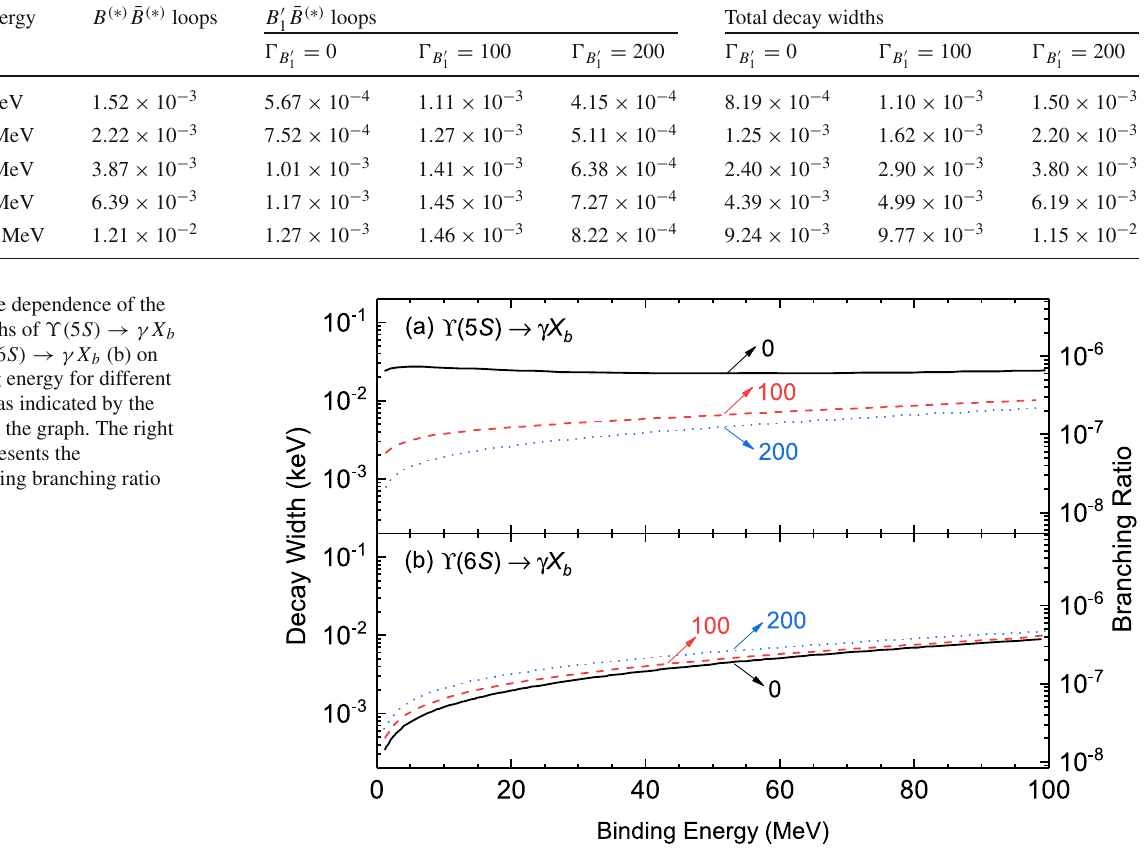
to be 0, 100, and 1